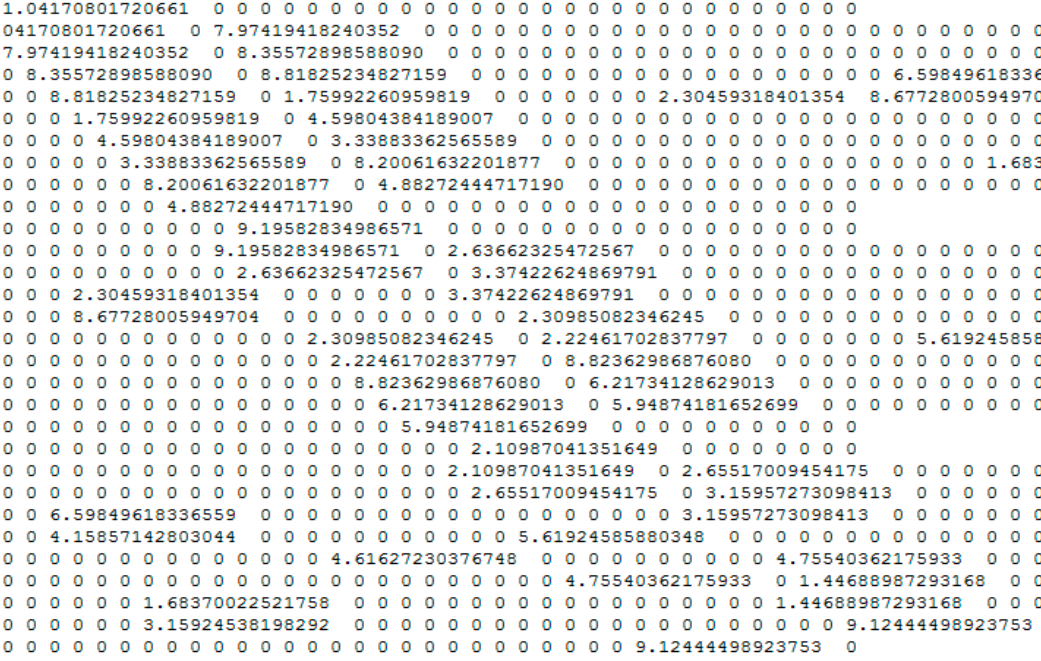
Figure 9. Part of simulated public transport network authorized adjacency matrix.